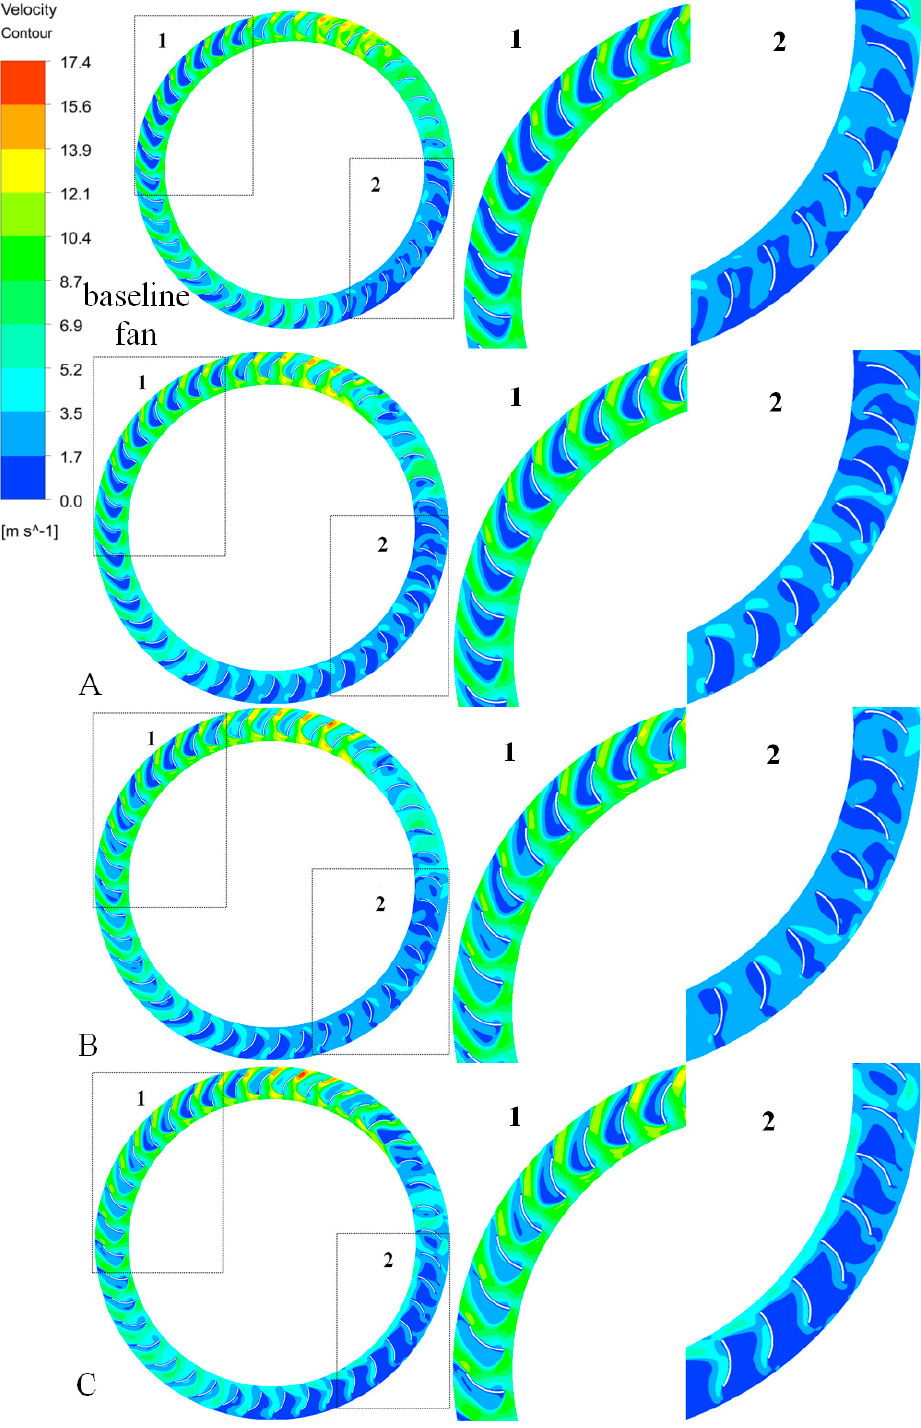
Figure 11. Magnitude of absolute velocity of the impeller for the z = 35 mm plane at a rated flow rate Q / Q n = 1.000: ( A ) model-A; ( B ) model-B; ( C )